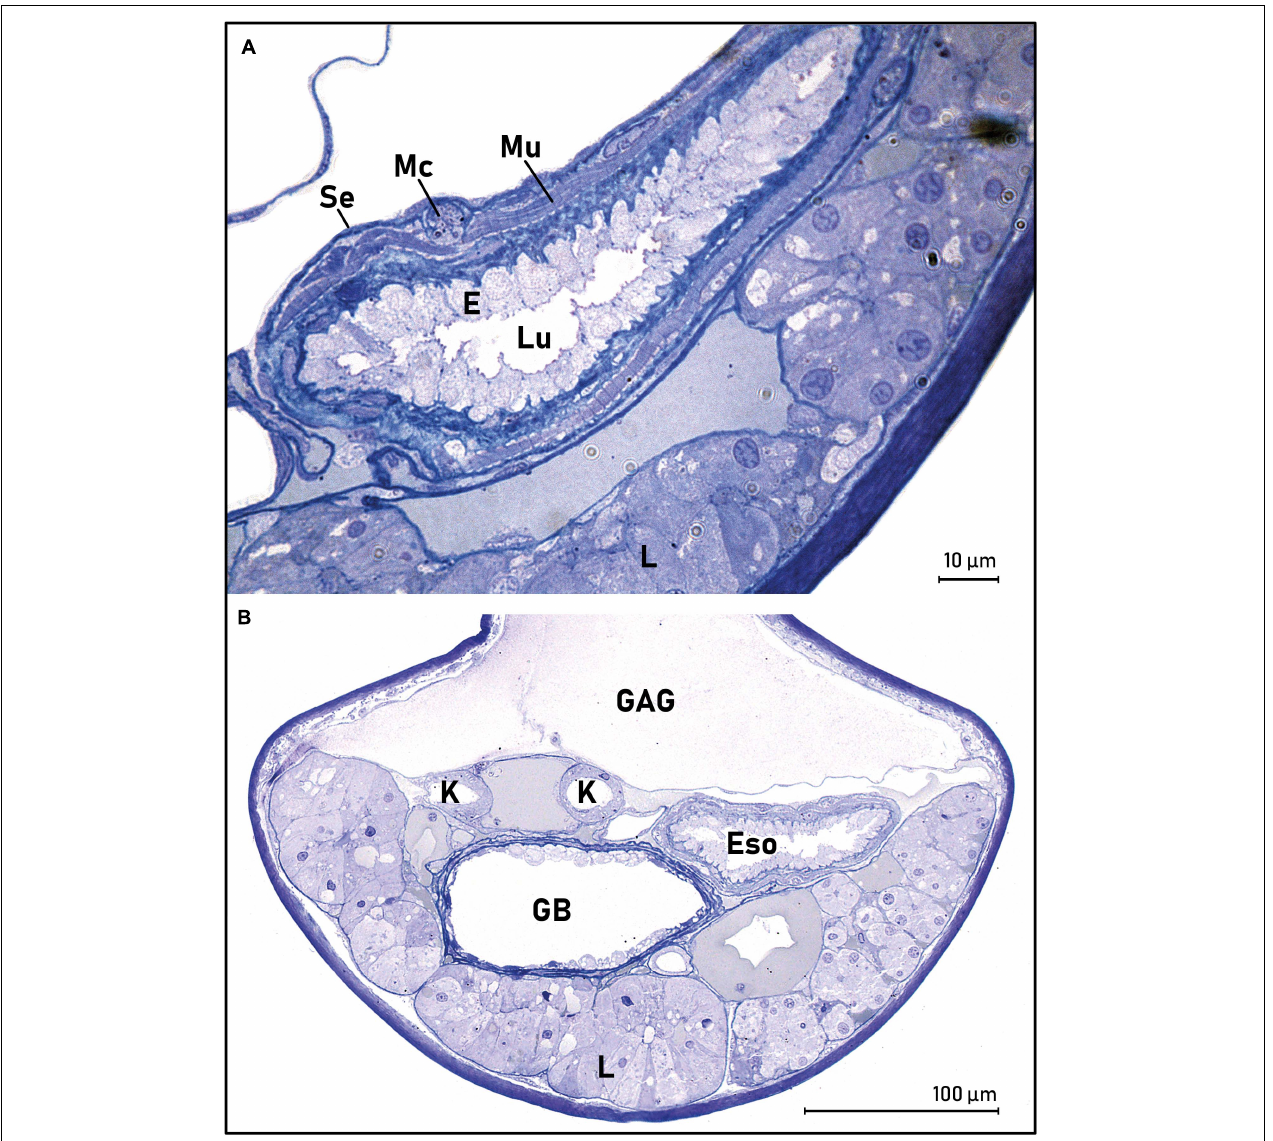
FIGURE 7 | Middle part of esophagus (A) and transition area between the esophagus and intestine of leptocephalus larvae of the European eel (B) ( Anguilla anguilla ) (L21, SL = 23.33). (A) The esophagus with a thick surface epithelium (E), striated muscularis externa (Mu), and serosa (Se). The liver (L) is also present. (B) The liver is present, esophagus (Eso), kidneys (K), and the gall bladder (GB). The glycosaminoglycan layer (GAG) is visible above the digestive tract. Abbreviations: E, epithelium; Eso, esophagus; GAG, glycosaminoglycan; GB, gall bladder; K, kidney/nephric ducts; L, liver; LP, lamina propria; Lu, lumen; Mu, striated muscle; Se,